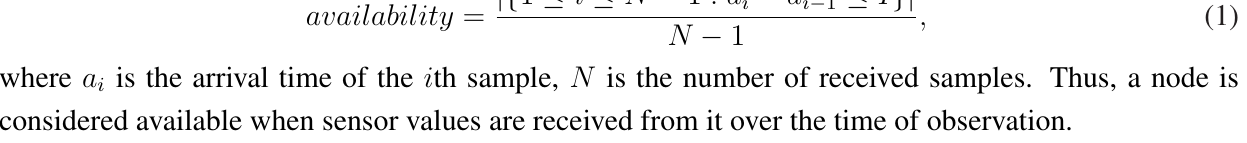
Figure 4. Availability metric expressing the probability that an update is received from a node within certain time interval. Packet drops and network errors decrease the